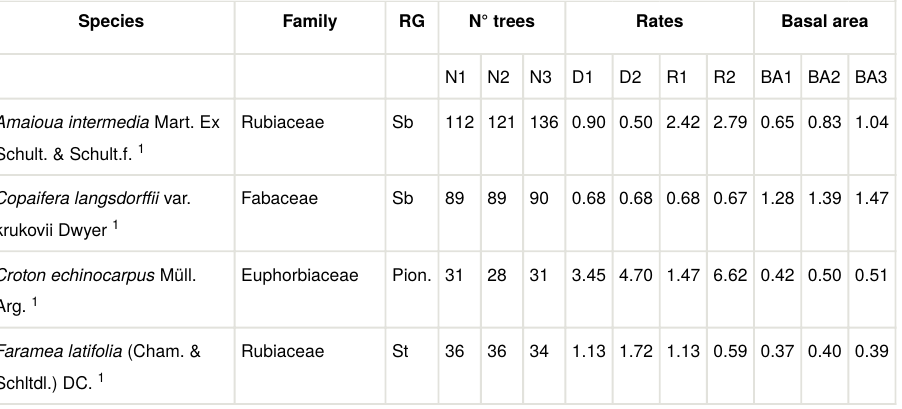
Dynamics of tree populations most abundant in the forest of the Parque Ecológico Quedas do Rio Bonito, municipality of Lavras, South of Minas Gerais State, Southeast Brazil. RG = regeneration guilds (following: Garcia 2012, Oliveira Filho et al. 2007). St = shade tolerants; Ld = light- demanding; Pion. = pioneer; N1, N2 and N3 = total number of trees in each one of the three inventories; and BA1, BA2 and BA3 = basal area in each one of the three inventories, respectively; D1 e D2 = rates of mortality in both analyzed periods; R1 and R2 = recruitment in both analyzed periods. 10 most abundant ones in stand B and in stand C, respectively.